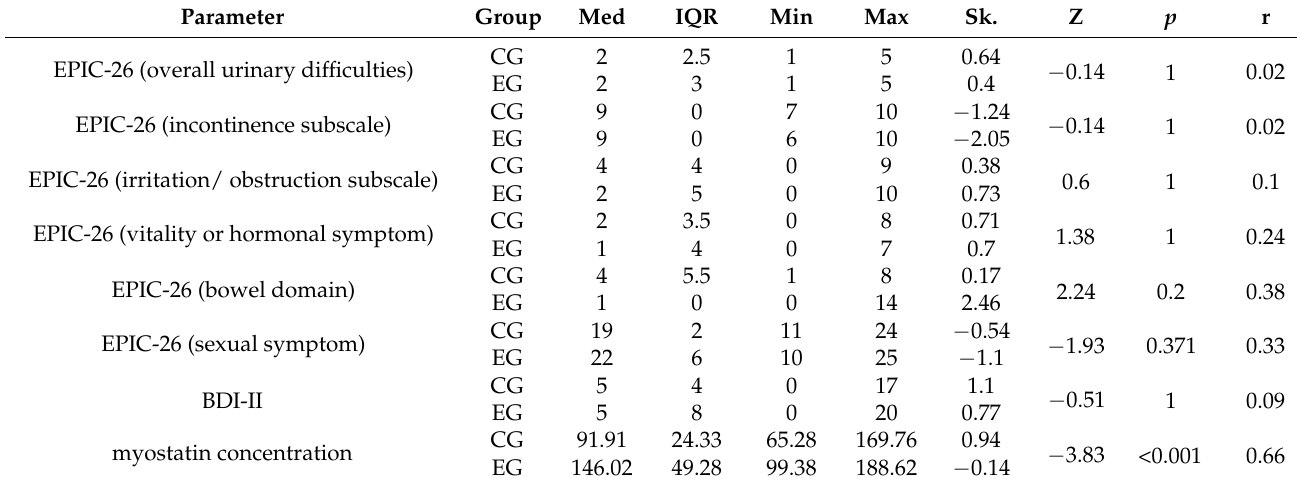
Table 2. Comparative analysis of all measured variables for the EG and the CG at the initial assessment. Parameter Group